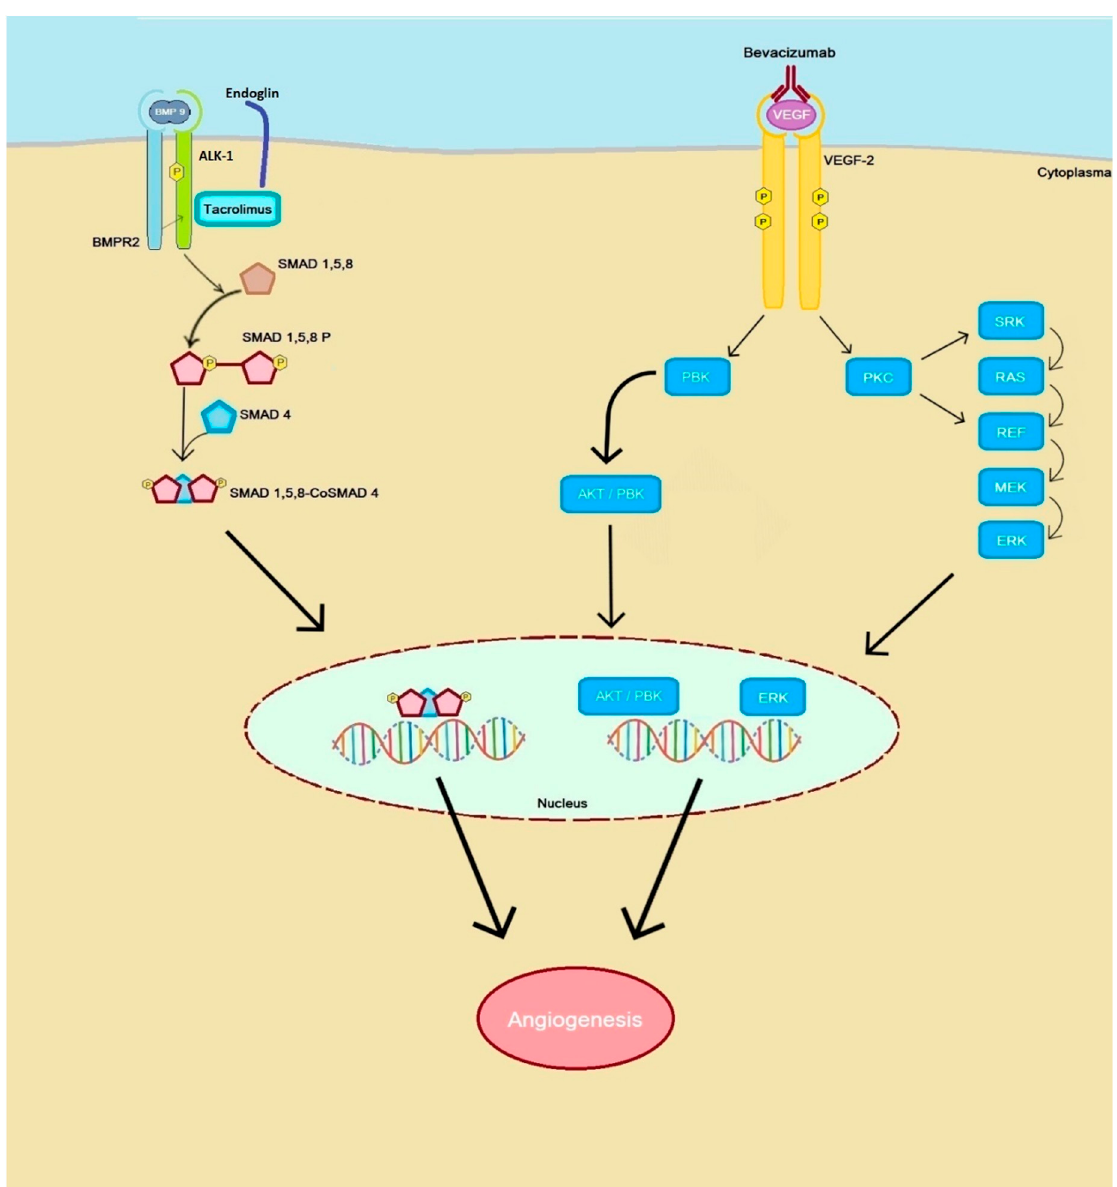
Figure 2. Schematic model of the targets of bevacizumab and tacrolimus. Bevacizumab binds VEGF signaling molecules that prevent (vascular endothelial growth factor) VEGF from binding effectively to the VEGFR2 receptor and as a result it reduces neoangiogenesis. Bevacizumab enhances the BMP9-ALK1-ENG-SMAD pathway and enhances ENG and ALK1 expression.